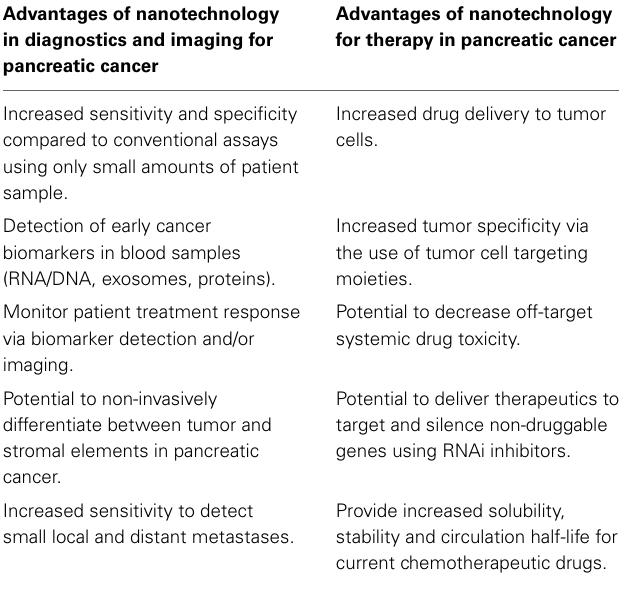
Table 1 | Potential advantages of nanotechnology for the diagnosis and treatment of pancreatic